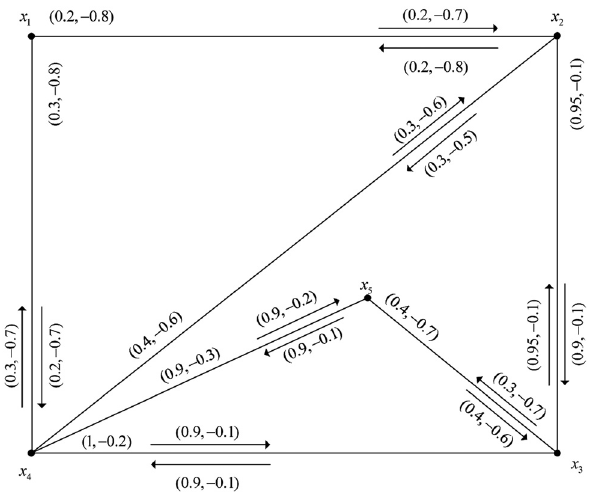
Figure 2: A BFIG with